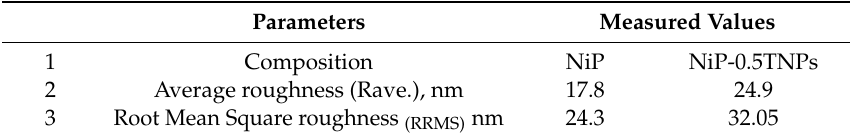
Figure 12. The 3D Surface topographic images for NiP ( a ) and NiP-0.5TNPs ( b ) coatings of 50 h heat treatment in an open furnace condition. Table 7. Comparison of the roughness parameters for NiP and NiP-0.5TNPs nanocomposite coating after 50 h heat treatment in an open furnace condition.